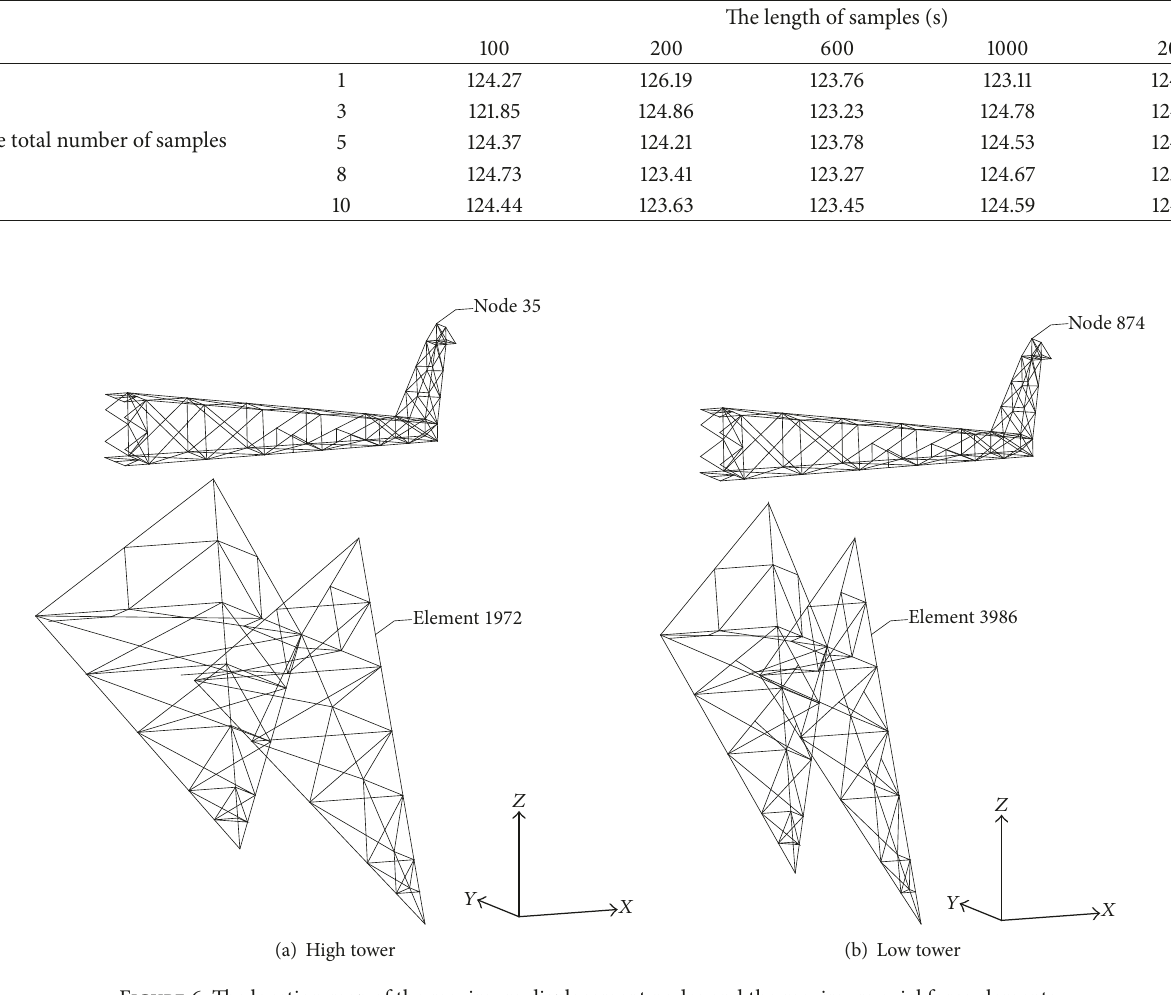
displacement value is not consistent with one sample. The relative error of the statistical results for the number of more than one sample is no more than 2%, and the deviation is